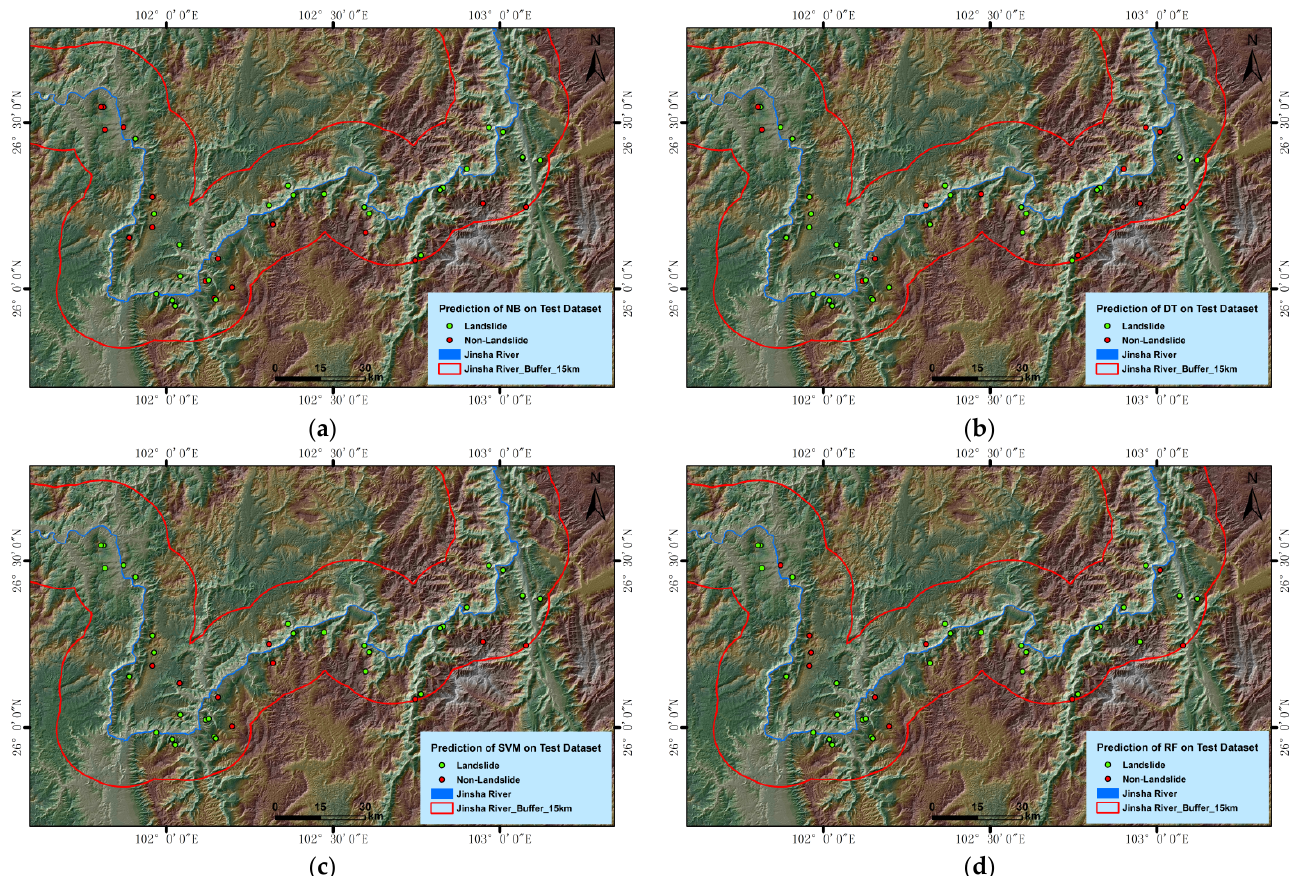
Figure 8. Prediction results of 4 Machine-Learning methods. ( a ) Prediction result of NB; ( b ) Prediction result of DT; ( c ) Prediction result of SVM; ( d ) Prediction result of RF.